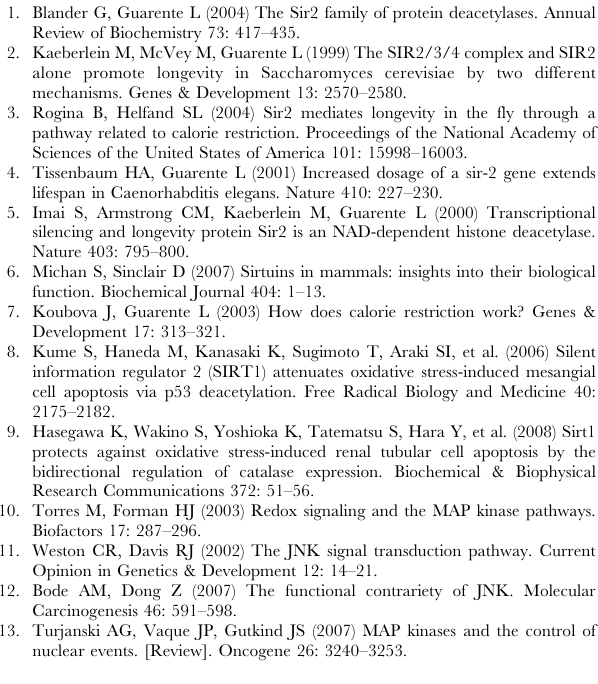
Table S1 The primers used to create the mutant SIRT1 are described in this